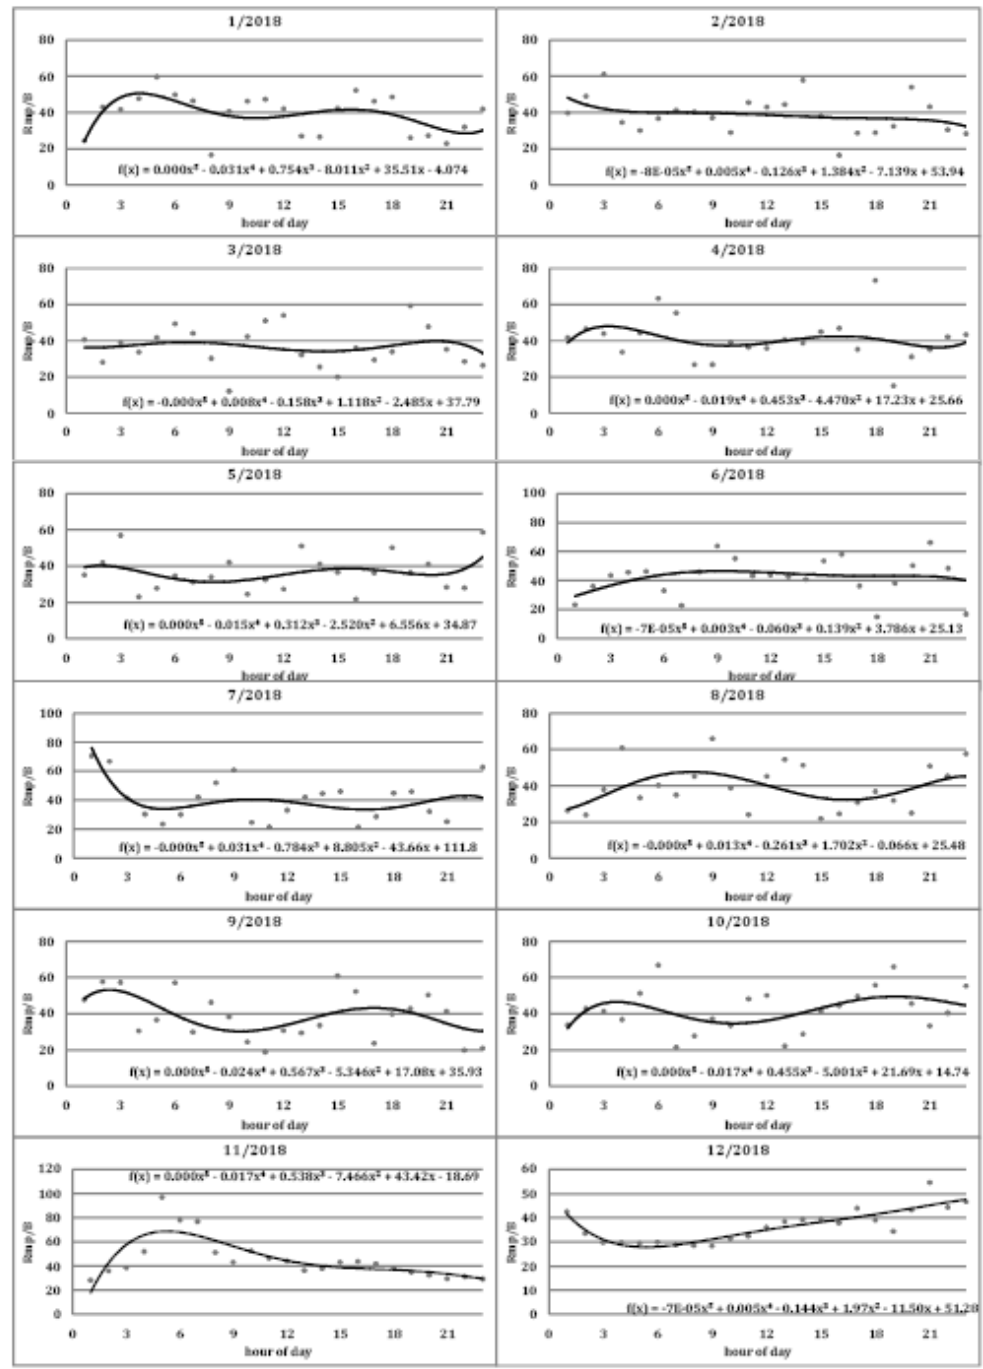
Fig. 5: Monthly median of (Rmp /Bo) for year